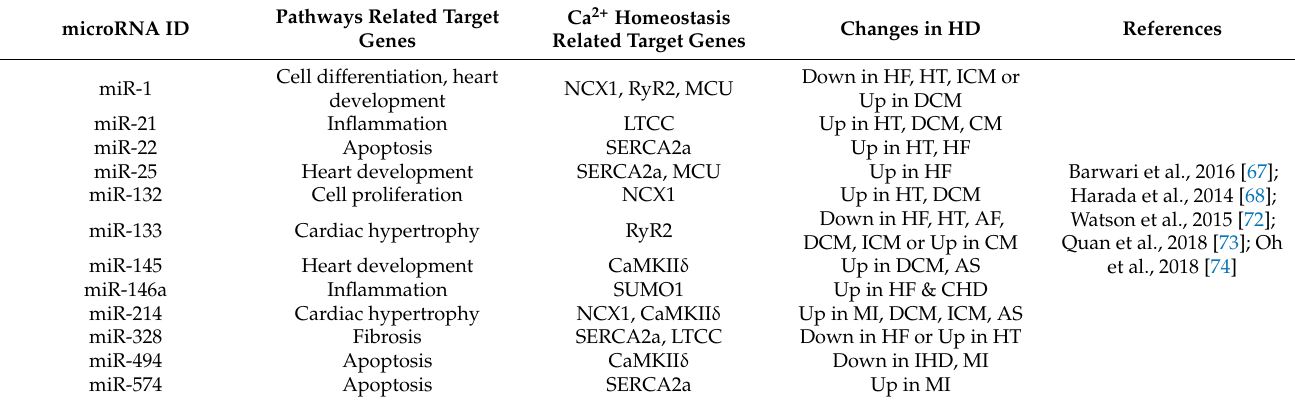
Table 2. Calcium Regulating miRNAs in Heart